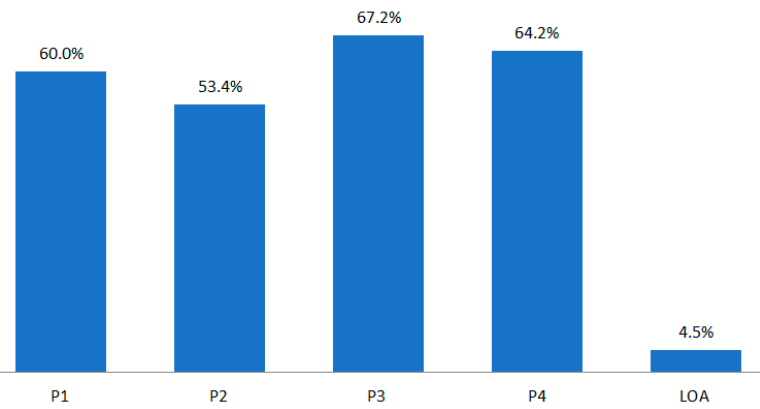
/ LOA by BLA drug class for the whole period (1970–2017). Figure 3. POS/LOA by BLA drug class for the whole period (1970–2017). Figure 3. POS NDA and BLA show a di ff erence of 1.0% and 5.1%, respectively, in terms of the LOA of P1–P4. There is a 2.0% di ff erence in terms of all drugs (NDA + BLA). It is desirable to readjust this considering that post-marketing POS and pre-marketing LOA in P4 are low at approximately 17%, as shown in Figure 3